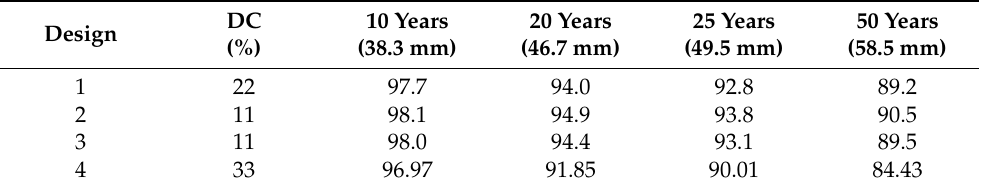
Table 5. Comparison between functional resilience of the four optimal layouts during different design storms.